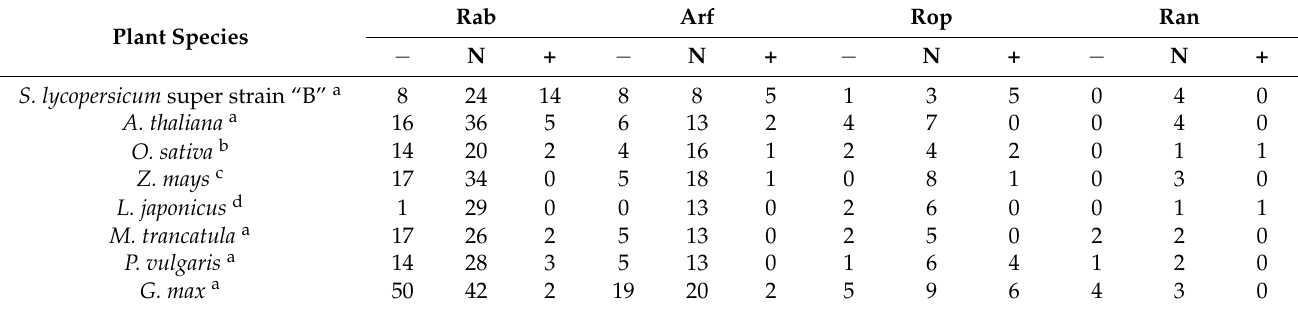
Table 4. The number of each GTPase subfamily member that shows no change (N), reduced ( − ), or increased (+) levels of mRNA in Solanum lycopersicum super strain “B” compared with some non-leguminous and leguminous plants retrieved from the database in aerial tissue vs. the root. Rab Arf Rop Ran Plant Species − N + − N + − N + − N